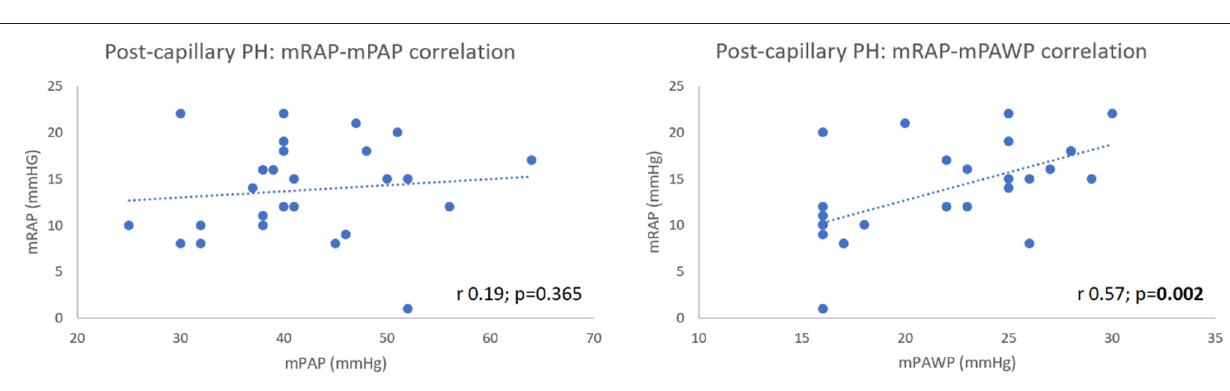
FIGURE 5 | mRAP-mPAP and mRAP-mPAWP relationships in post-capillary PH